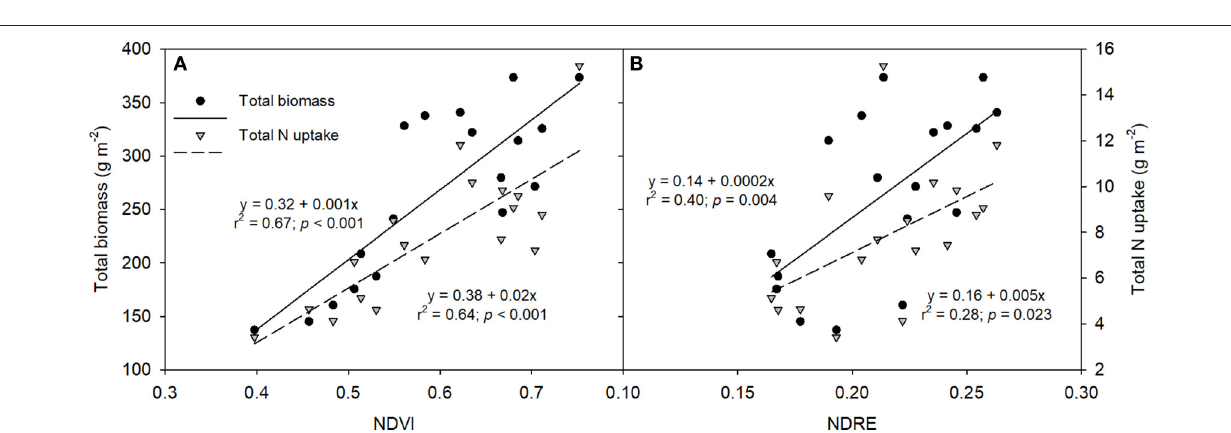
FIGURE 5 | Relationships of plant biomass (A) and nitrogen (N) uptake (B) with both Normalized Difference Vegetation Index (NDVI) and Normalized Difference Red Edge (NDRE) at growth stage